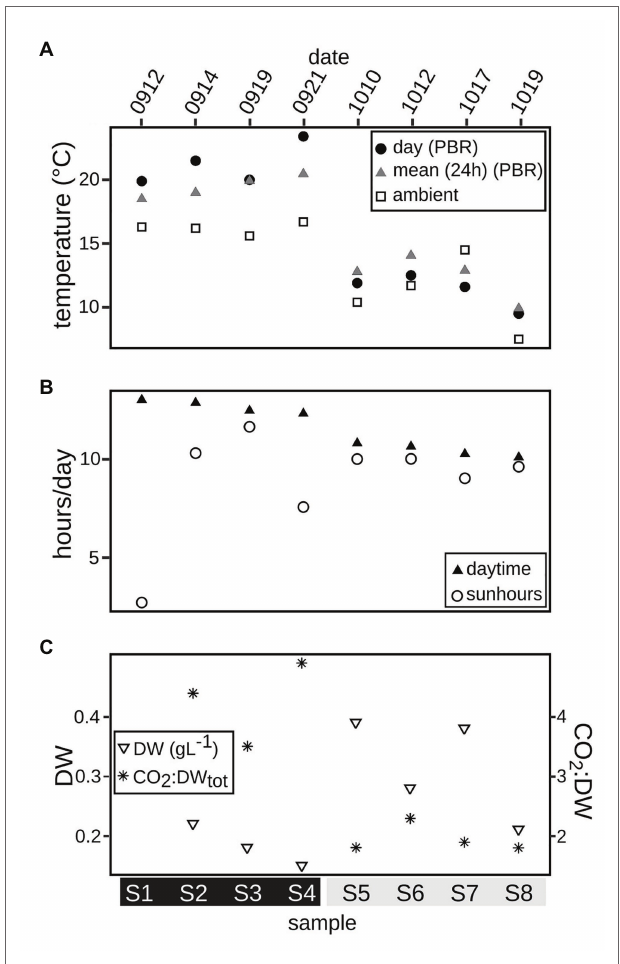
FIGURE 1 | Parameters associated with the photobioreactor (PBR) during the sampling period, dates of sampling specified on top, sample names S1– S8 at the bottom. (A) Daytime temperature ( ° C) in PBR (closed circles), mean temperature per 24 h in PBR (gray triangles), regional ambient daytime temperature (measured by SMHI; open squares). (B) Number of hours day -1 with sunshine (direct solar radiation > 120 Wm –2 , 10 km south of PBR location; open circles), daytime hours/day (black triangles). (C) For S2–S8 sampling events (S1 omitted due to lack of data), left y -axis: Dry weight (DW) of biomass (gl −1 ; open triangles) and right y -axis: ratio of flow in added mass (g) of CO 2 :total dry weight (in 3200 L;